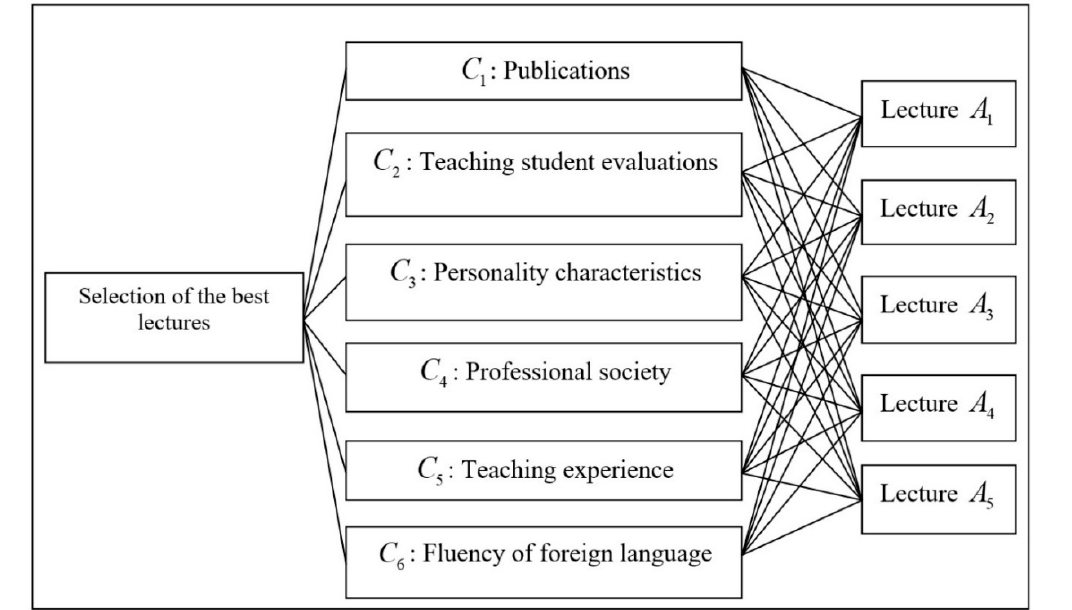
Figure 2. Evaluation lecturer’s performance problem.